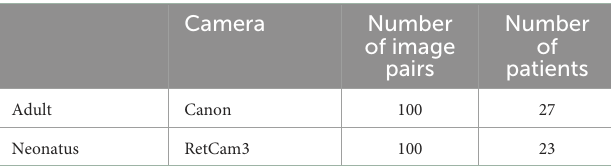
TABLE 1 Details of our constructed AN-200